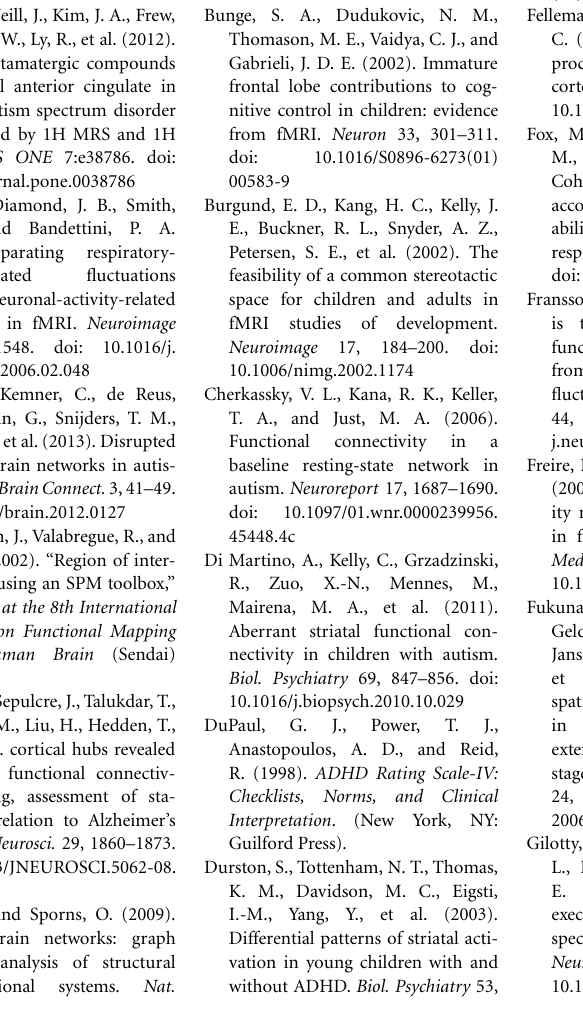
FIGURE S4 | State differences in seed-based connectivity maps within each group, for three clusters showing Group × Task interaction: left orbital frontal gyrus (BA 11) (left panel), left middle frontal gyrus (BA 10) (middle panel) and left premotor (BA 6/9) (right panel). Region numbers 1–3 on the left corner in the brain image correspond to the region number in Figure 1 . FIGURE S5 | State differences in seed-based connectivity maps within each group, for three clusters showing Group × Task interaction: left premotor (BA 8) (left panel), left premotor (BA 6) (middle panel) and SMA (BA 32/8) (right panel). Region numbers 4–6 on the left corner in the brain image correspond to the region number in Figure 1 . FIGURE S6 | State differences in seed-based connectivity maps within each group, for three clusters showing Group × Task interaction: Paracentral Lobule (BA 6) (left panel), right Angular Gyrus (BA 39/40) (middle panel) and Posterior MTG (BA 19/39) (right panel). Region numbers 7–9 on the left corner in the brain image correspond to the region number in Figure 1 .